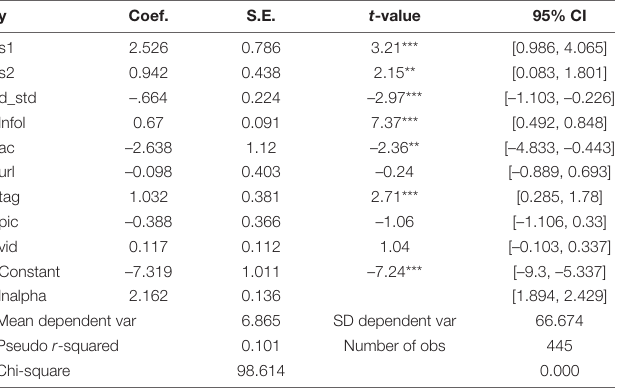
TABLE 5 | Negative binomial regression results: sample 3. y